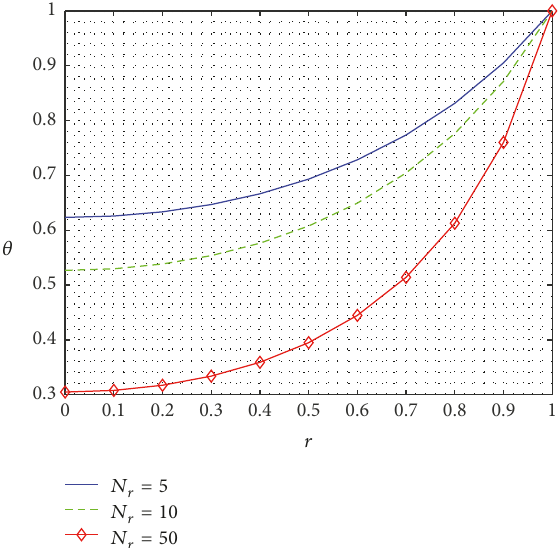
Figure 4: Plot of the temperature with 𝜃 𝑎 = 0.2 , 𝑟 ∗ = 1/1.75 , and N = 1 for 𝑇 = 100 and varied values of N 𝑐